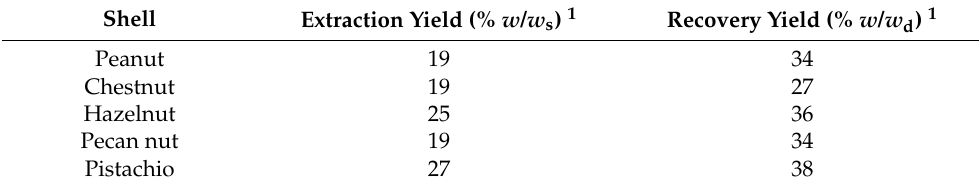
Table 1. Lignin extraction and recovery yields from selected nut